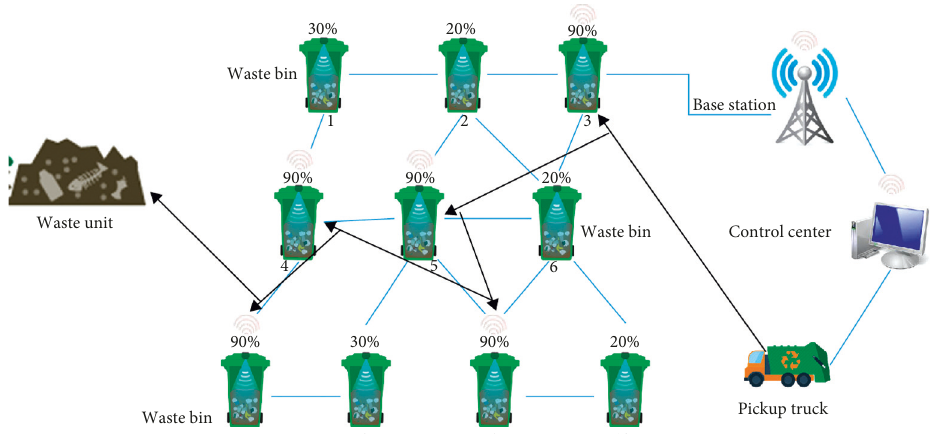
Figure 2: The proposed smart waste management system.